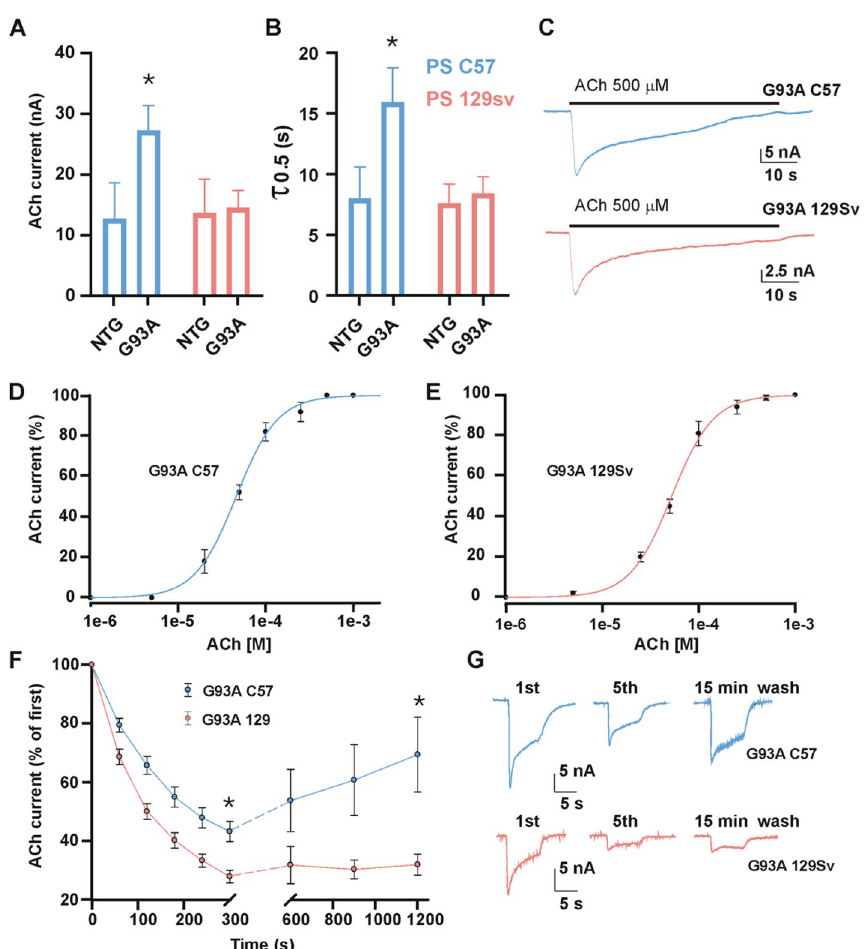
Fig. 4 Nicotinic acetylcholine receptor activity in fast- and slow-progressing mice. A and B The bar graphs represent mean SEM of ACh-evoked ± currents amplitude ( A ) and ACh decay time ( B ). C Representative current traces elicited during prolonged ACh application (500 μM for 60 s) in one oocyte (representative of 12 and 16 for G93A C57 and G93A 129sv, respectively) injected with G93A C57 (blue) or G93A 129Sv muscle membranes. D and E Dose-response curves obtained by plotting the amplitude of currents evoked by ACh concentrations ranging from 1 μM to 1 mM, expressed as a percentage of the maximal current evoked at 1 mM ACh, represented as mean SEM and best fitted with Hill curves. Averaged EC 50 ± values and n H in oocytes injected with G93A C57 were 47.0 0.23 μM and 1.9 0.2; in oocytes injected with G93A 129Sv, the values were 54.0 ± ± ± 3.0 μM and 1.3 0.1. F ACh-evoked current desensitisation (first six dots) followed by evaluation of current recovery after 5, 10, and 15 minutes of ± washout from the last pulse of the desensitisation protocol. Currents were normalised at the amplitude of the first ACh application ( ● 26.1 6.6 = ± nA, n 19; ● 13.0 1.2 nA, n 29. ( G ) Representative ACh-evoked current traces at different time points, as indicated in the = = ± =